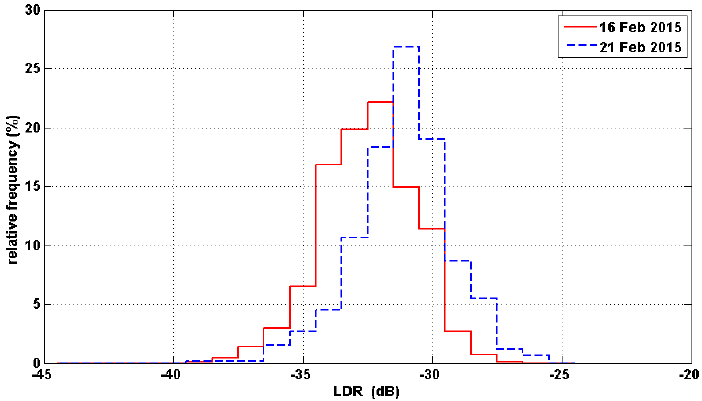
Figure 28. Linear depolarization ratio (LDR) histograms for the graupel and snow band cases.